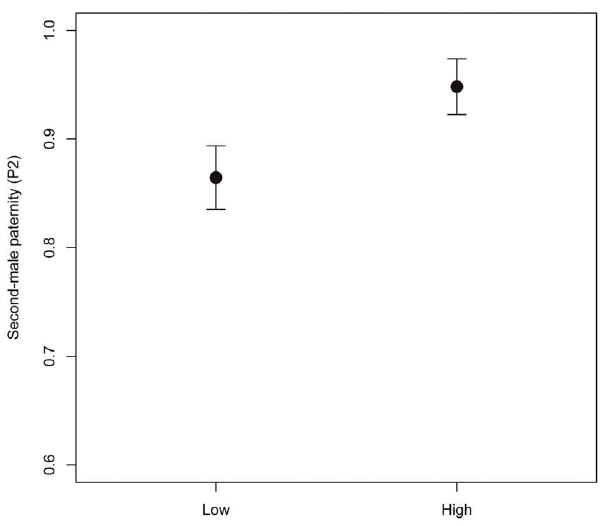
Figure 1. Relative offensive sperm competition success, given as second-male paternity (P2; mean + / 2 SE), for high- and low condition males. Sperm competition success was measured as the proportion of offspring produced by high- or low condition males relative to a standard competitor mated to a given female. High condition males showed significantly higher P2 relative to